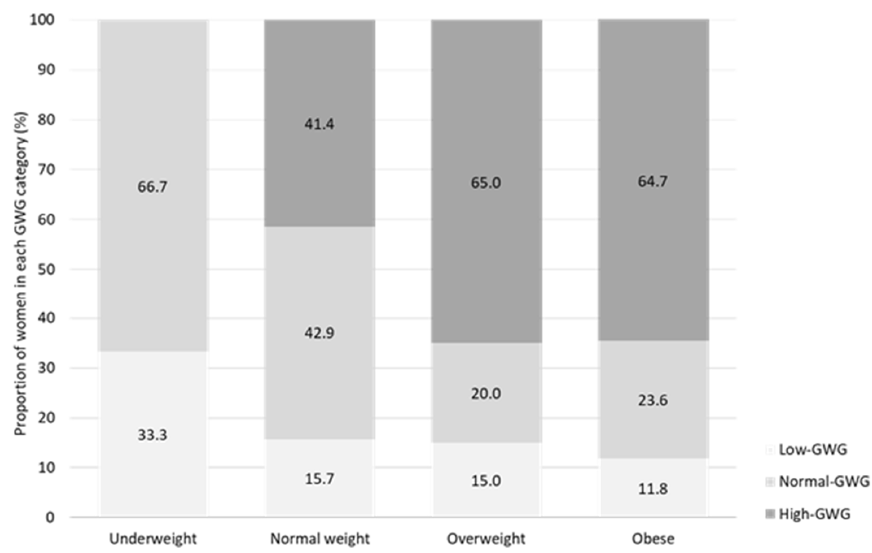
Figure 2. Weight gain according to IOM guidelines [27] depending on weight classification. GWG, gestational weight gain. Table 2. Participants’ characteristics (mean ± SD/ n (%)).